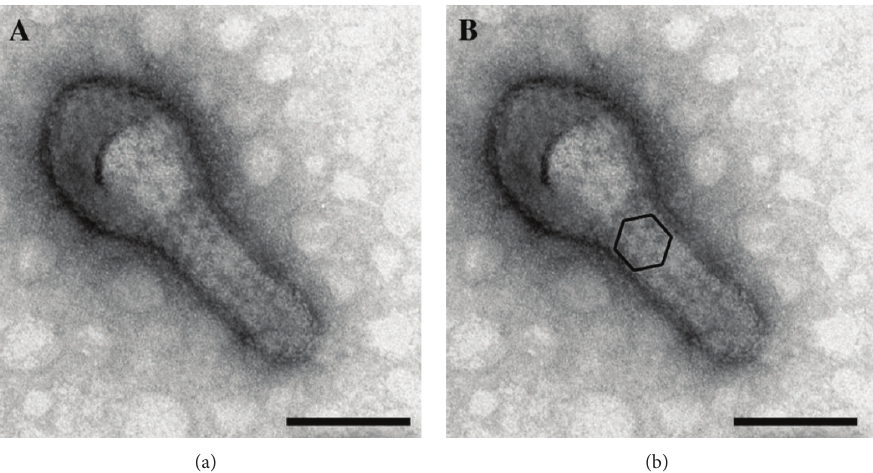
Figure 8: Electron micrograph of a negatively stained furin double mutant E1-392/E2-341. (a) A normal E1-392/E2-341 particle that shows surface detail. (b) The same particle (a) highlighting a hexagonal array clearly visible on the tubular structure. Bars, 100 nm. Kononchik et al. 2009 [53].